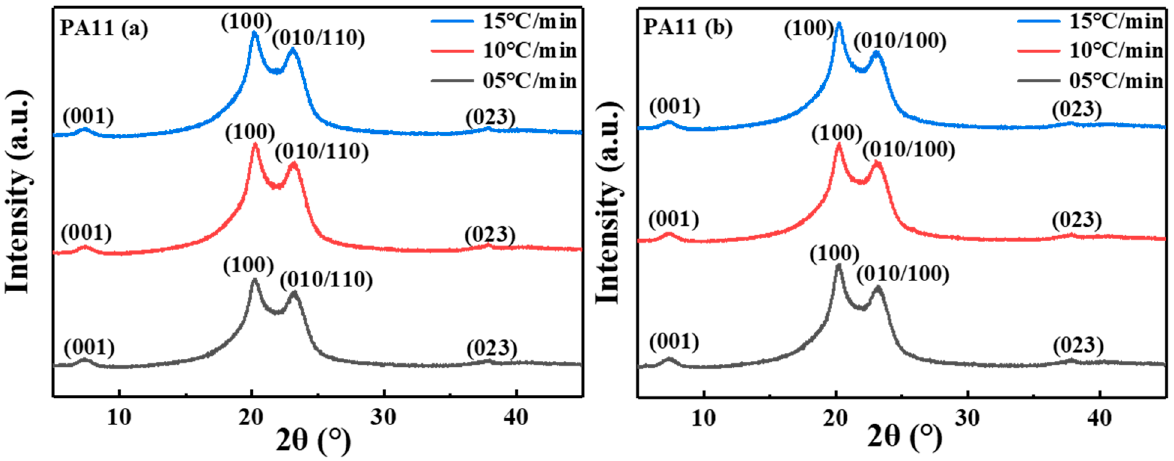
Figure 9. Diffractograms recorded for two PA11 crystallized samples. Table 4. 𝐿 (cid:3035)(cid:3038)(cid:3039) to different crystal planes of PA11 samples with different cooling